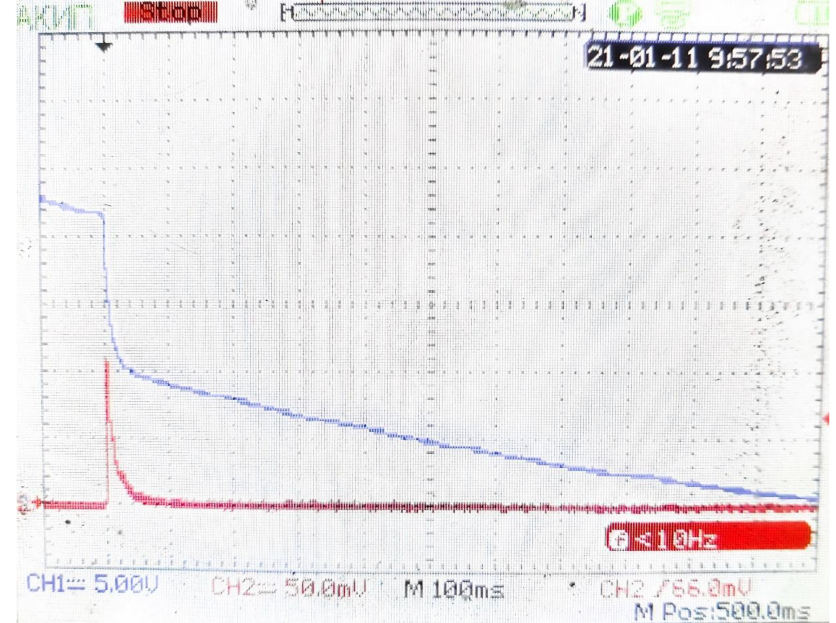
Figure 13. Enlarged graph of the current